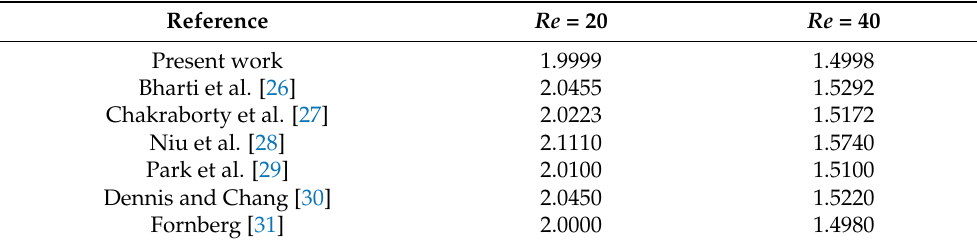
Drag variation for various Reynolds numbers in the current study compared to previous